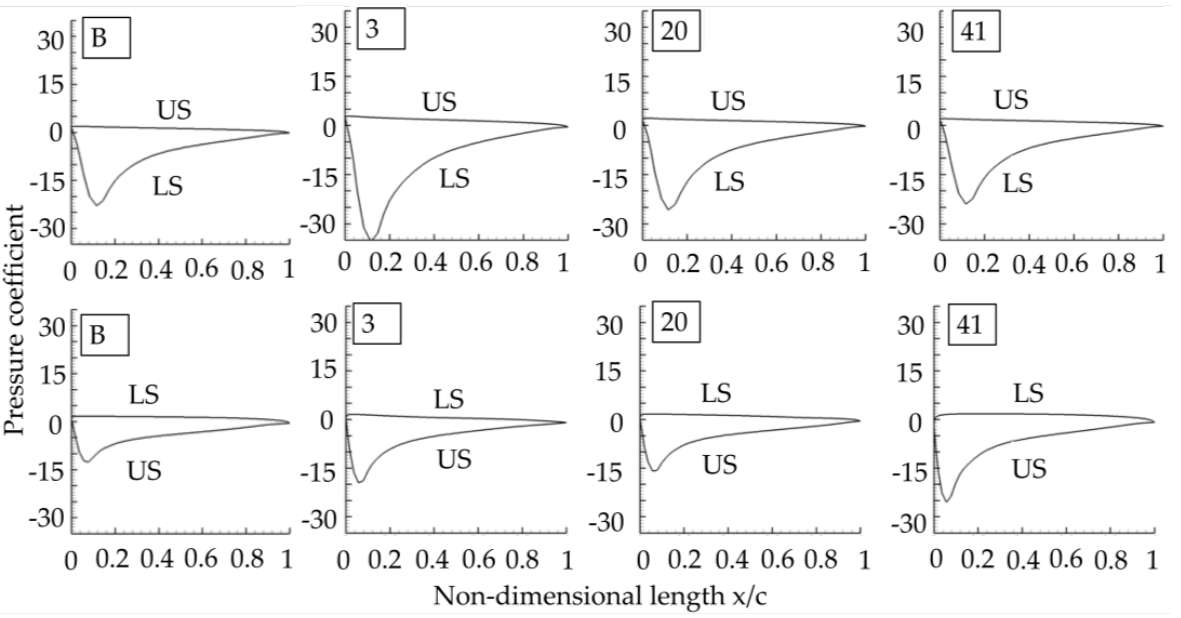
Figure 17. A comparison of pressure distributions around the oscillating hydrofoil with an upstream deflector at different deflector–hydrofoil spacings J * (upper surface (US) and lower surface (LS) (first row: t / T = 0.2; second row: t / T = 0.65).